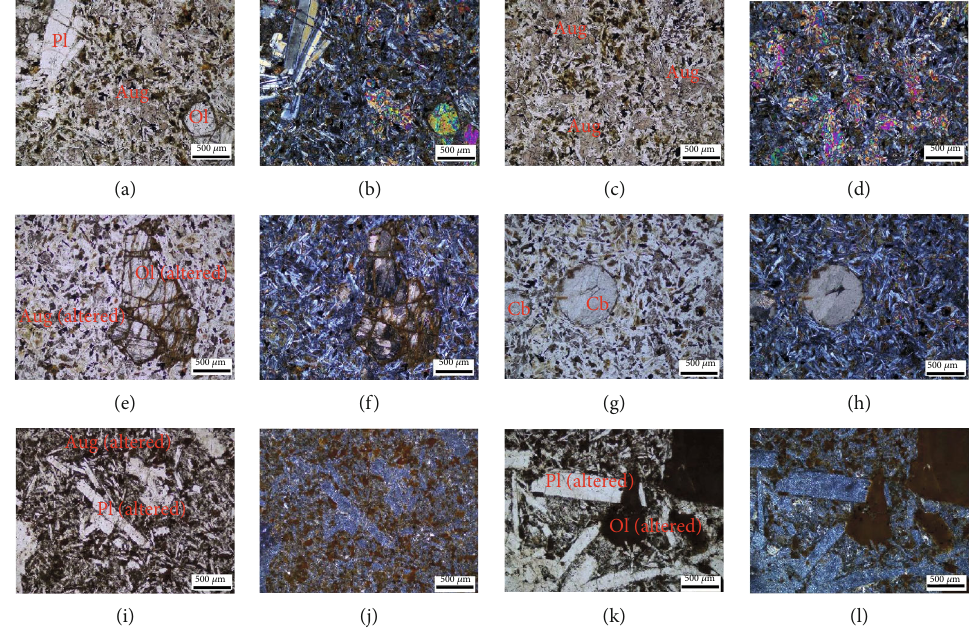
Figure 5: (a) Plane-polarized light (PPL), (b) cross-polarized light (XPL), (c) PPL, and (d) XPL photomicrographs of TS3. Euhedral plagioclase (Pl), olivine (Ol) (the cracks and margins of olivine changed into serpentine), and subhedral augite (Aug) were partially altered into chlorite and smectite. (e) PPL and (f) XPL photomicrographs of TS5. Augite was mostly converted into carbonate and mixtures of chlorite and smectite, while euhedral olivine was completely converted into carbonate minerals. (g) PPL and (h) XPL photomicrographs of TS5. Carbonate mineral spherulite (Cb). (i) PPL, (j) XPL, (k) PPL, and (l) XPL photomicrographs of TS2. Euhedral plagioclase was completely replaced by fi ne-grained clay minerals, and ma fi c minerals were completely converted into brown mixtures of chlorite, smectite, and carbonate